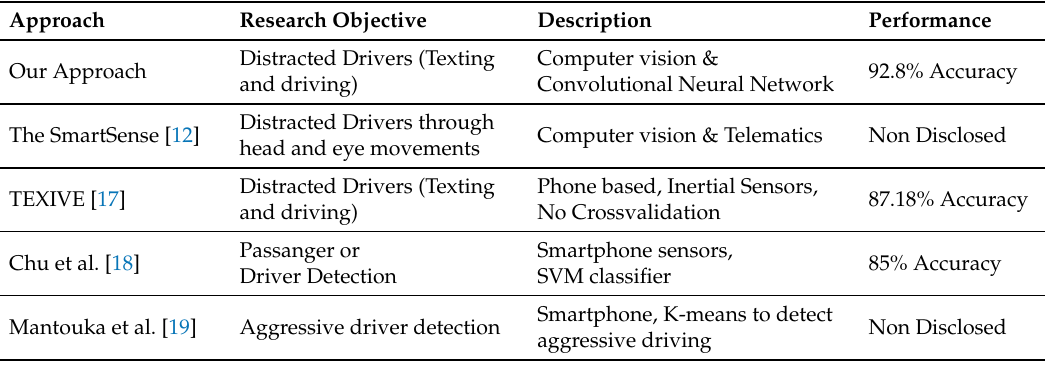
Table 2. Performance comparison of related